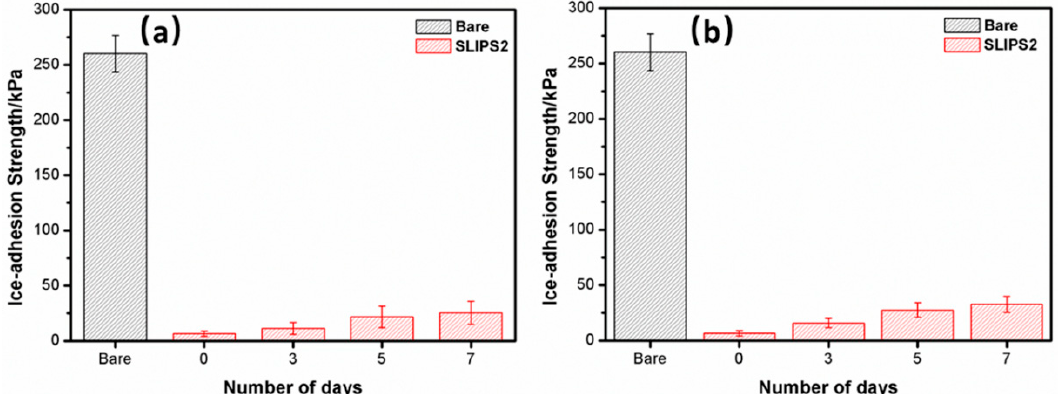
Figure 9. ( a ) variation of ice-adhesion strength of SLIPS2 under thermal condition at 75 °C for 7 days; ( b ) variation of ice-adhesion strength of SLIPS2 under UV light exposure for 7 days.